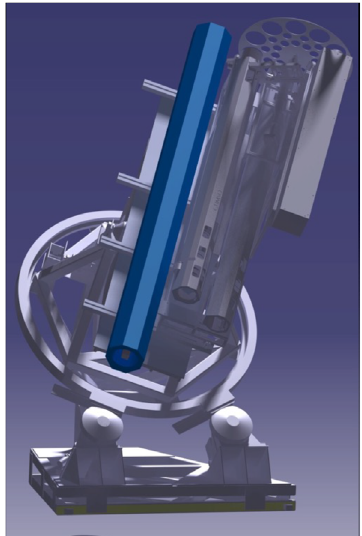
Fig. 14. 3D-model of the C3 coronagraph (in blue) by the other CLIMSO instruments ’